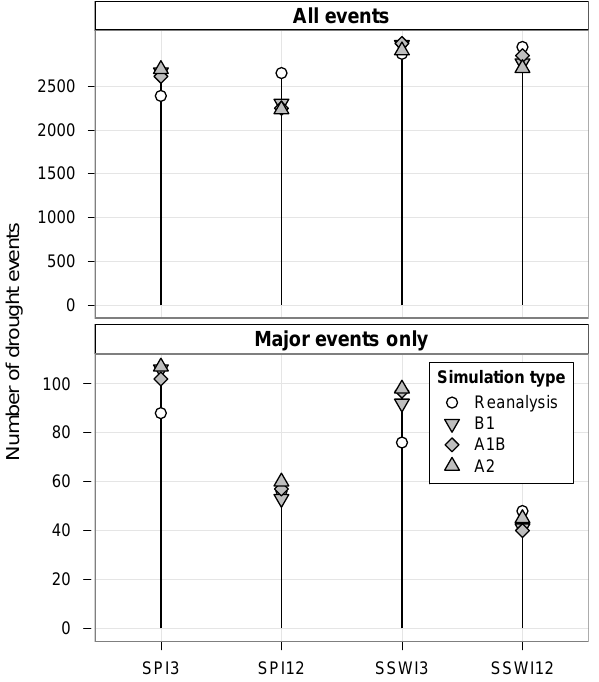
Fig. 3. Number of drought events identified over the 1958–2008 pe- riod, for reanalysis data and all 3 simulations. Top panel: all events; bottom panel: only major events (duration > 1